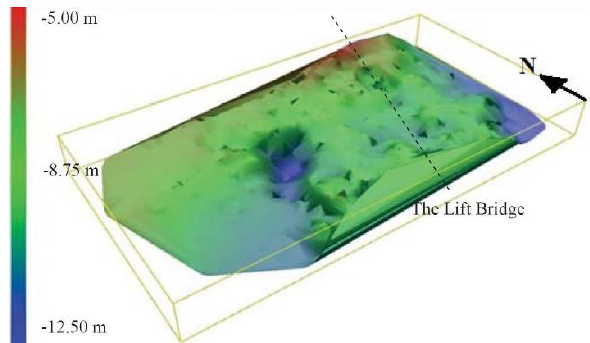
Figure 9. Three Dimensional View of the Second Study (Under the Lift Bridge) Area Using the Polar Boat Data on AutoCAD Carlson